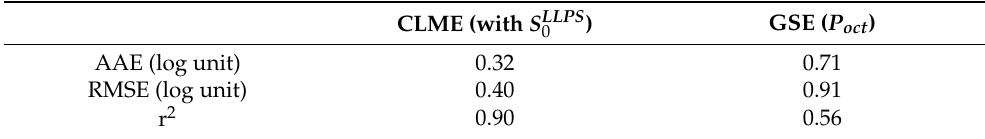
Figure 5. Correlation between P oct and S LLPS Table 3. Statistical correlation of CLME and GSE (N =